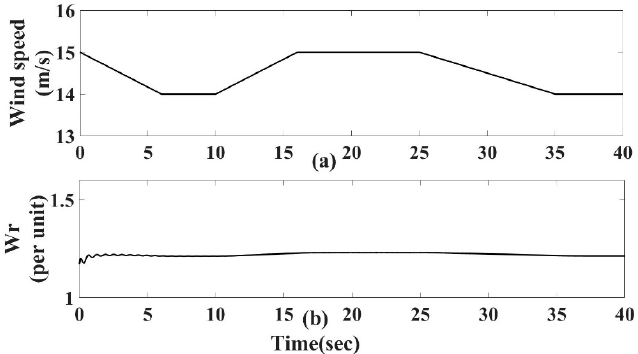
Figure 23. ( a ) Wind speed change and ( b ) generator speed per unit.